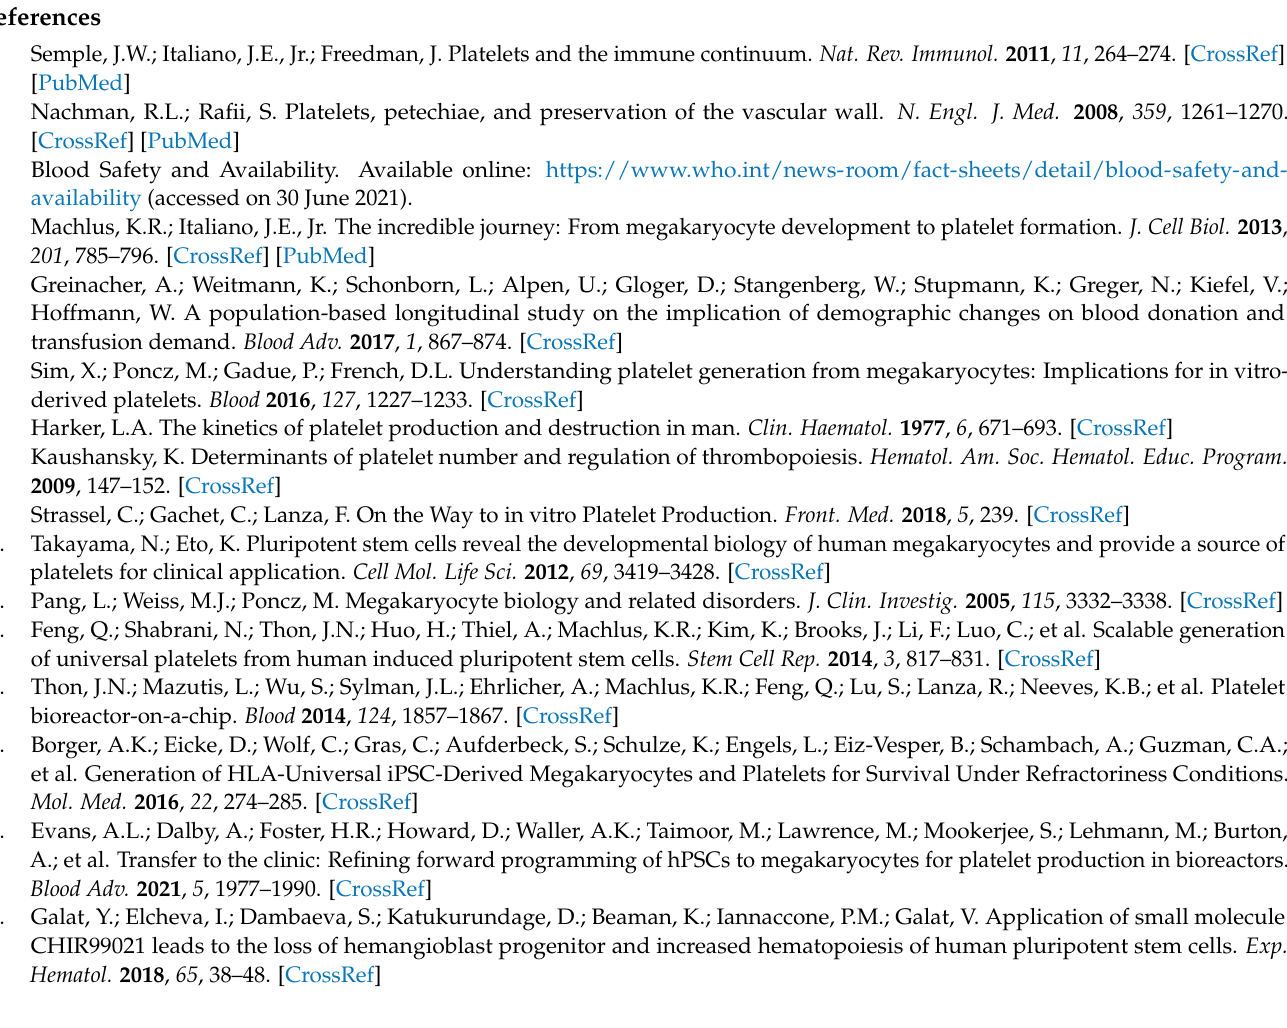
Figure A3. Illustration of hiPSC-derived platelet phenotype. The hiPSC-derived platelets were harvested d 9 + 7 from cultures using our improved protocol, fixed and stained for CD61 (green) and with mitotracker (red). Scale bar 2 µ m. Representative platelets were